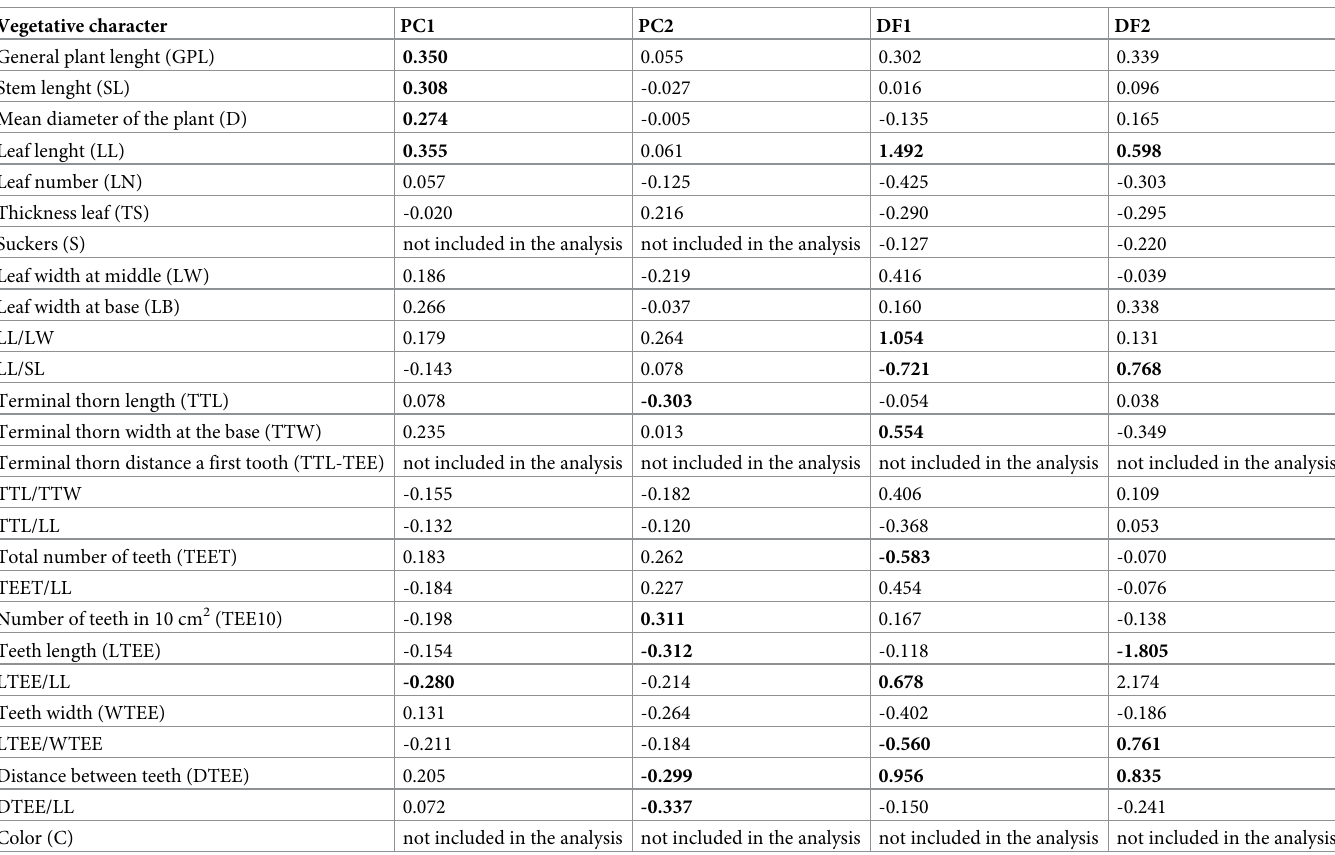
Table 3. Vegetative morphological characteristics measured in the traditional varieties of agaves recorded in the localities Rancho La Coyotera and El Cubo studied in the state of Hidalgo.